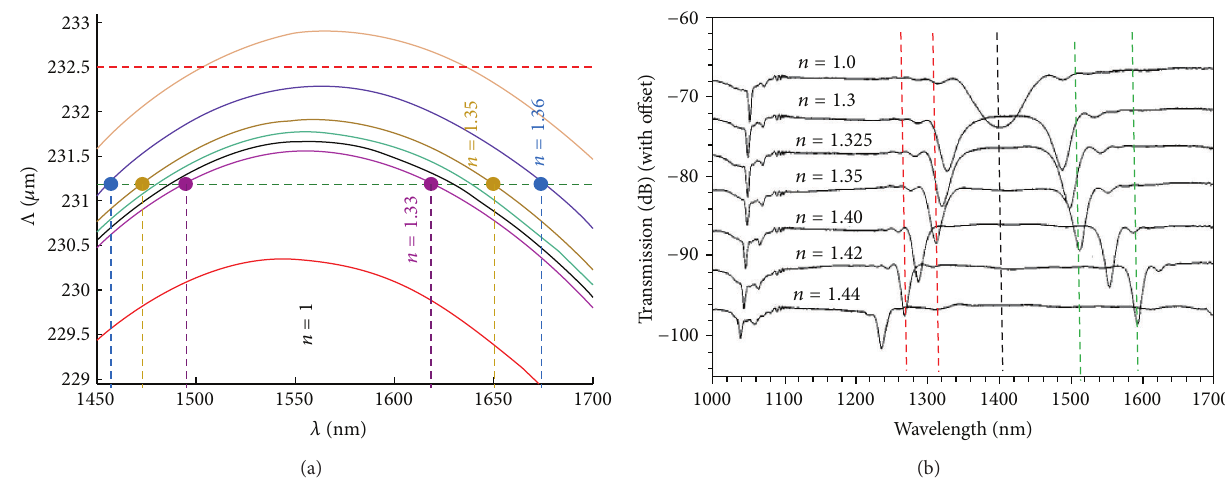
Figure 4: (a) Phase matching curve of a particular mode as a function of the external refractive index. (b) Displacement of the resonance wavelengths for different refractive indices (adapted from [27,